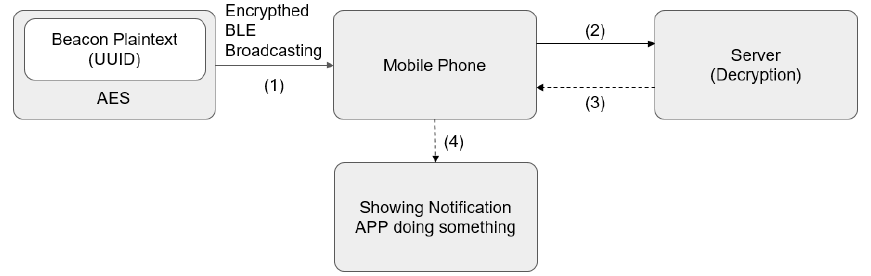
Figure 2. System diagram of the iBeacon system in this study.